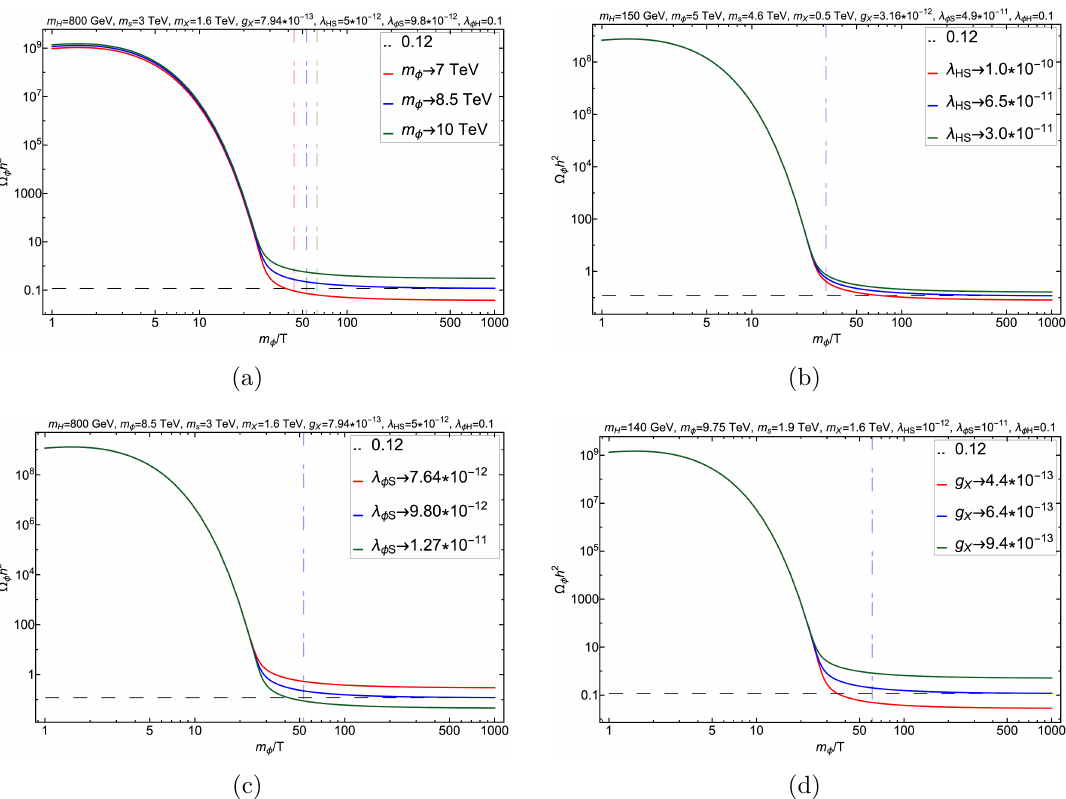
Figure 11 . WIMP relic density ( Ω φ h 2 ) in terms of x = m φ /T for three different values of parame- ters λ HS , λ φS , m φ , g X (from left to right and top to bottom) to provide correct relic, under and over abundance. The parameters kept fixed are mentioned in the insets as well as in the figure headings. The horizontal black dotted line denotes correct relic abundance and the vertical dot-dashed lines depict EWSB, x EW = m φ / 160